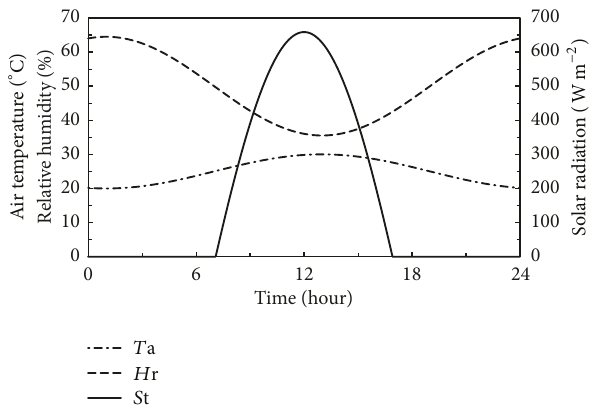
Figure 1: Diurnal variations of air temperature 𝑇 a , relative humidity 𝐻 r , and incoming shortwave solar radiation